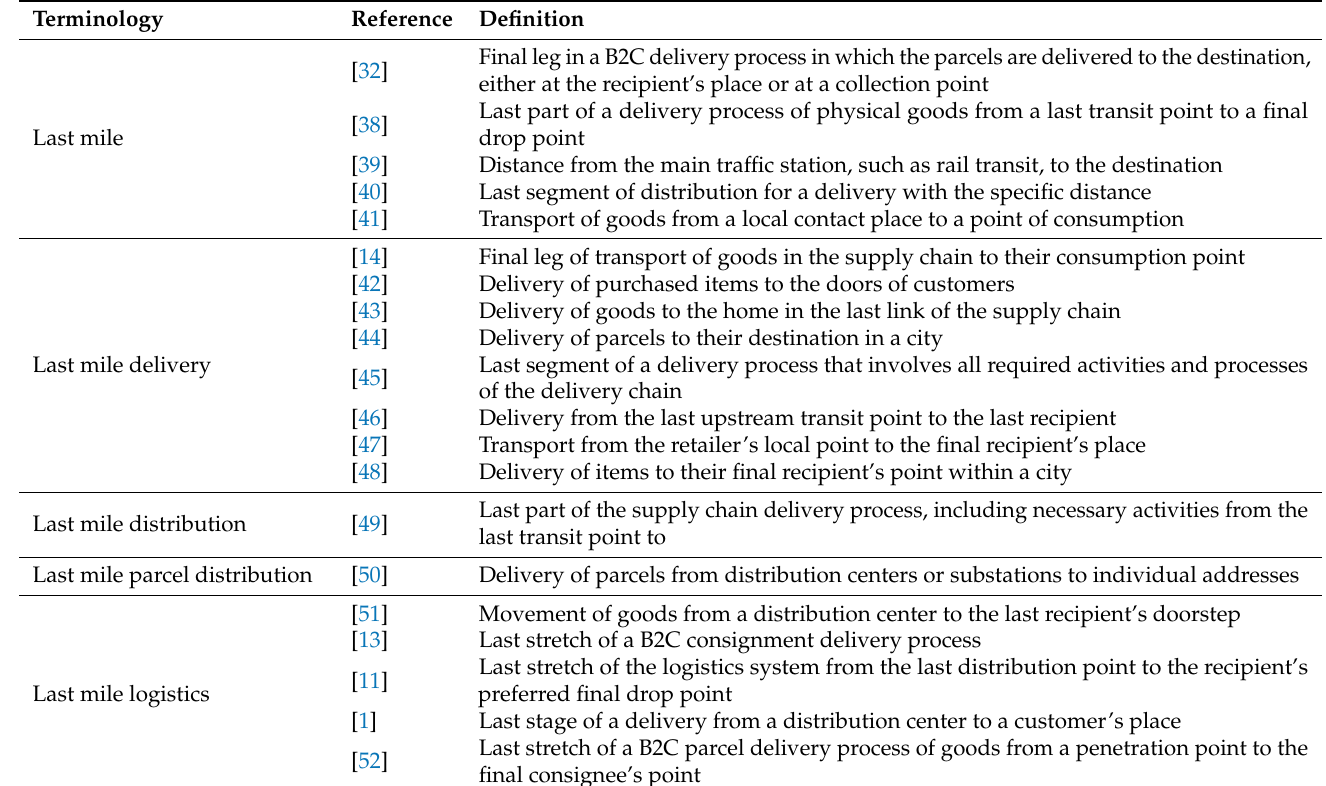
Table 1. Definitions of LML-related